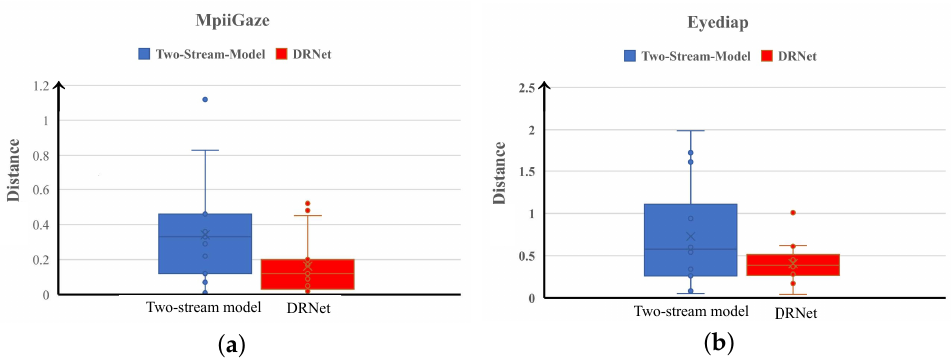
Figure 10. Box plots of the absolute distance of angular-error between the normal and noisy image using the two-stream model and DRNet in MpiiGaze ( a ) and Eyediap ( b